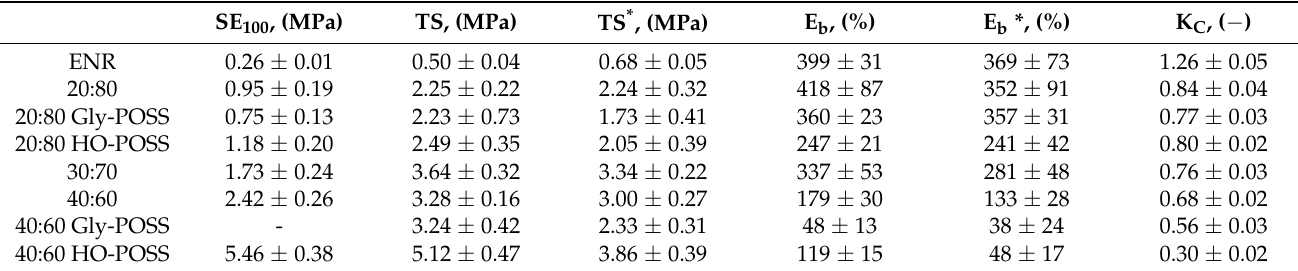
Table 3. Tensile mechanical properties of PLA/ENR blends before and after composting and the value of composting coefficient K C